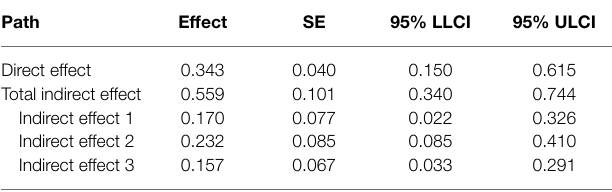
TABLE 5 | Mediation effects with